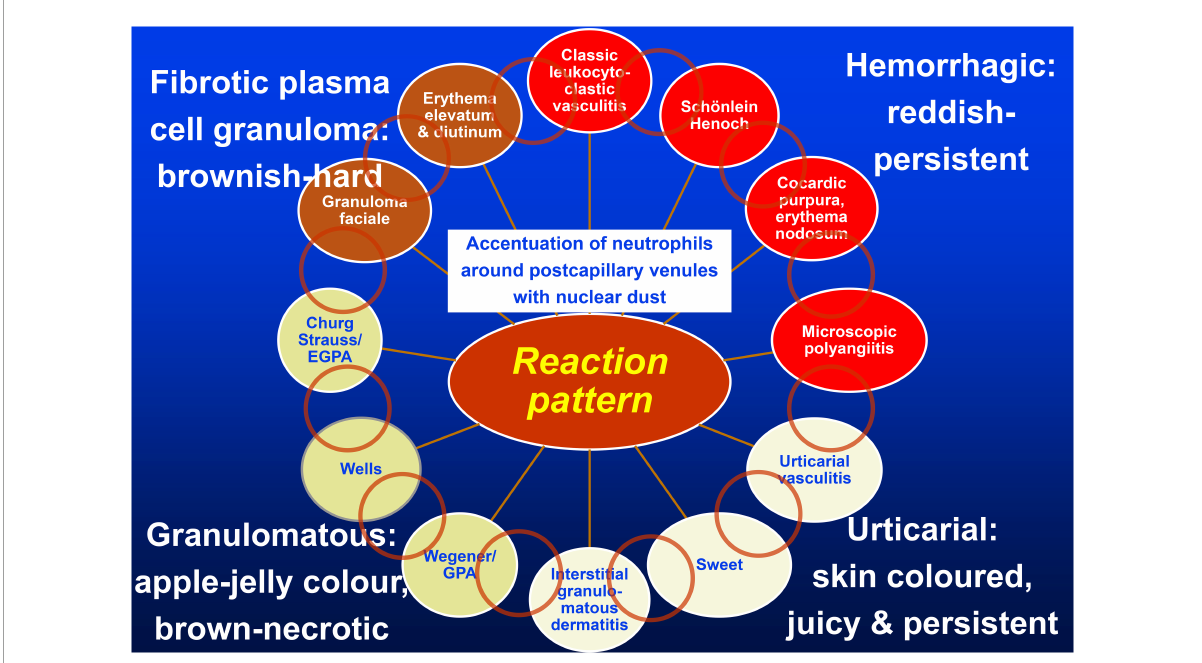
FIGURE1 Vasculitis wheel: Leukocytoclastic vasculitis with the accentuation of neutrophils around postcapillary venules and nuclear dust is the connecting histopathological finding. The clinical presentations of classic leukocytoclastic vasculitis, Schönlein Henoch purpura, cocardic purpura, and microscopic polyangiitis are typically hemorrhagic and thus reddish and persistent clinically and on diascopy; urticarial vasculitis, Sweet’s syndrome, and interstitial granulomatous dermatitis are urticarial and thus skin-colored, edematous, with only subtle hemorrhage, and no yellow/apple-gelee color on diascopy; GPA, Wells’syndrome, and EGPA are granulomatous and brown, with a yellow/apple-gelee color on diascopy. Necrotic lesions with erosions and ulcers may occur. Finally, granuloma faciale and erythema elevatum diutinum present as firm brown nodules . The light brown circles indicate individual clinical and histopathological overlap between the diseases. Published with permission from JDDG,